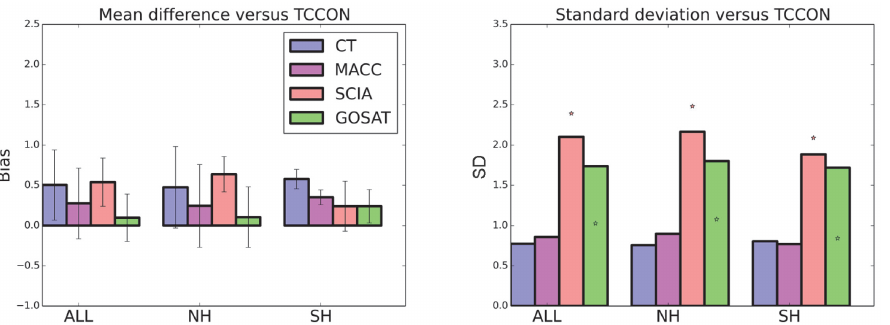
Figure 4. Overall bias (left panel, with error bars showing the standard deviation of the bias) and standard deviation (right panel, with stars showing the predicted error for satellites) for most stations (some stations removed, see